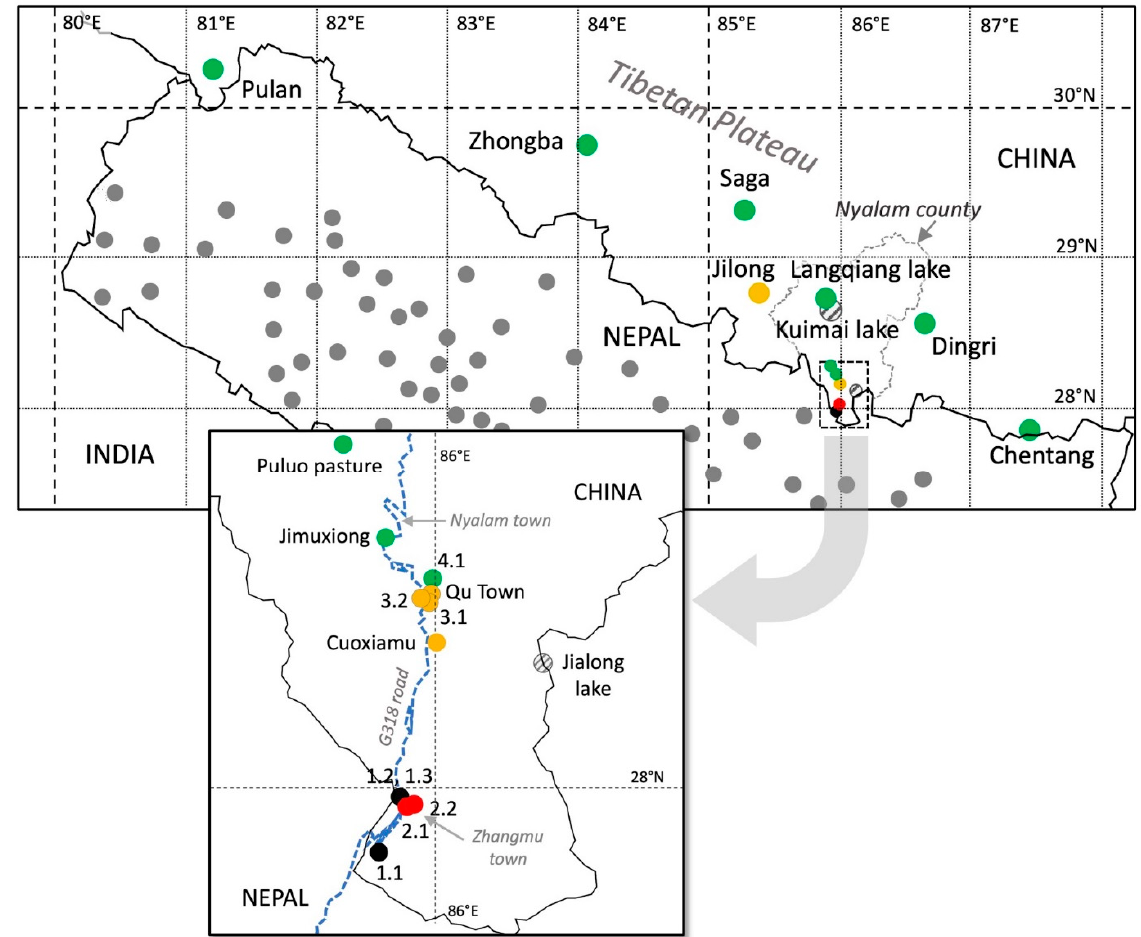
Figure 1. Desert locust records in Tibet in July 2020. Colored dots indicate the abundance of desert locust populations in Tibet: gray striped, none; green, none/very light/light; yellow, middle; red, heavy; black, very heavy. The gray dots in Nepal indicate desert locust reports (swarms or scattered populations) between June 27 and July 16 (modified from Shrestha et al., 2021). The box below the general map details the situation in southern Nyalam County where the degree of infestation was the most serious, along the G318 road (blue dotted line), for about 26 km along the Boqu River valley (1700 to 4200 m).